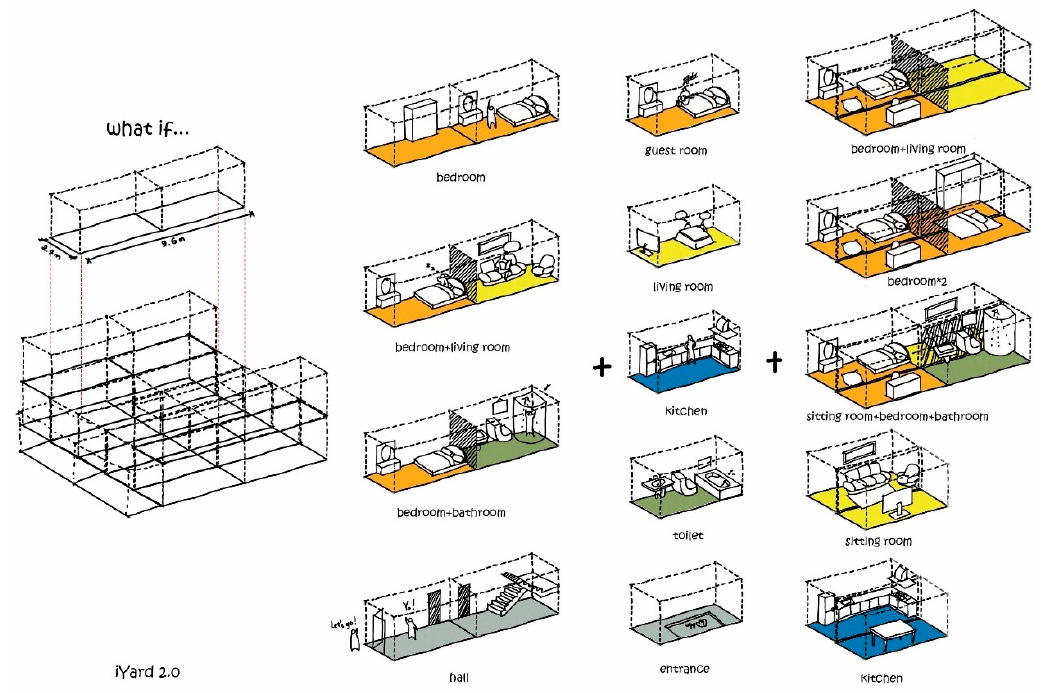
Figure 1. “Menu” for the independent customization model.